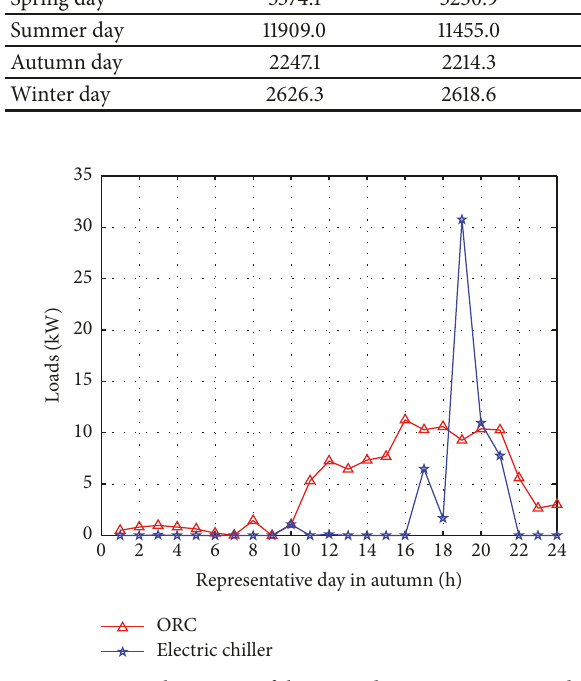
capacity in the CCHP system. In addition, efficiency of PGU is higher than that of the ORC. For the office building with low ratio of heat to power demand, power requirements are more than other requirements, so the capacity of PGU should be far larger than that of ORC. Through enumeration, the optimal capacity of PGU and ORC is 80kW and 20kW,